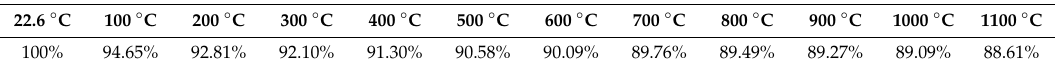
Table 6. Dependence of the mass of the nanopowder sample (wt.%) on temperature.